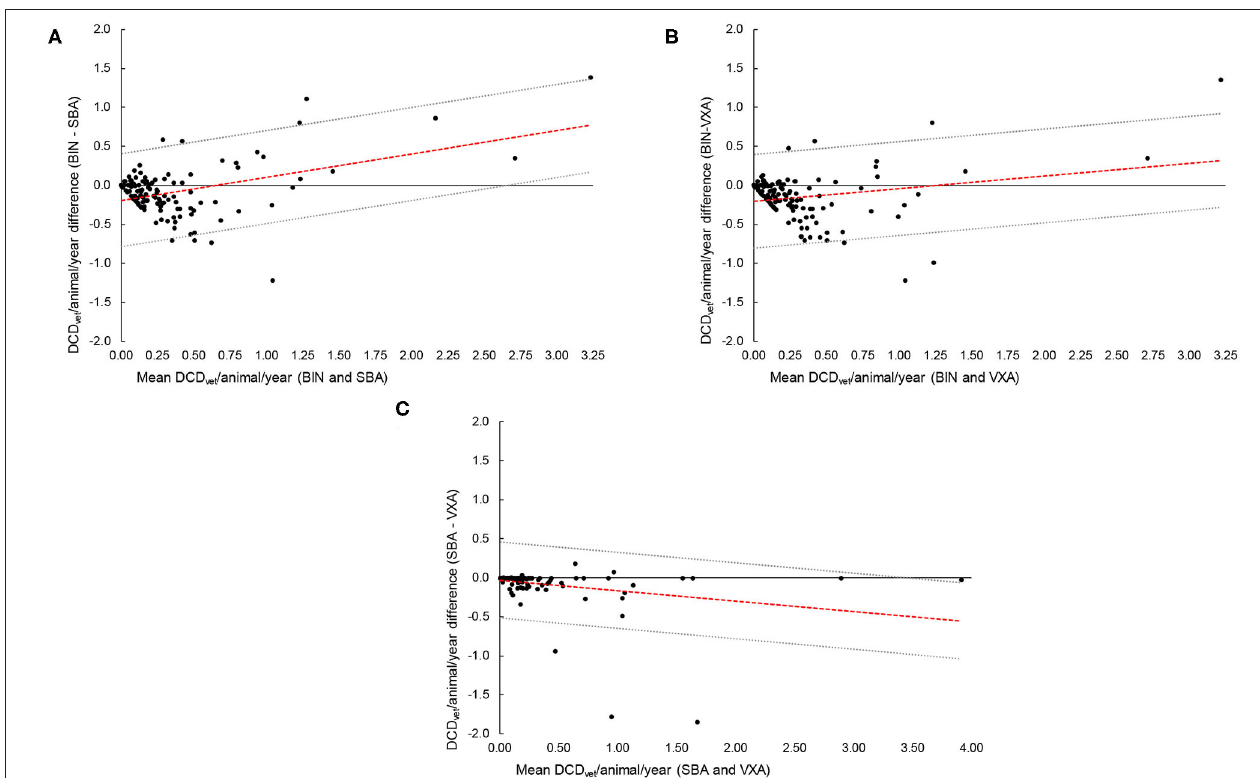
FIGURE 3 | Bland–Altman plots of (A) BIN vs. SBA dataset (B) BIN vs. VXA dataset and (C) SBA vs. VXA datasets on a sample of 60 farms in Sweden. ( −−− ) Regression line between the measures; (….) Limits of agreement for the regression line; (____) Line of equality (y =